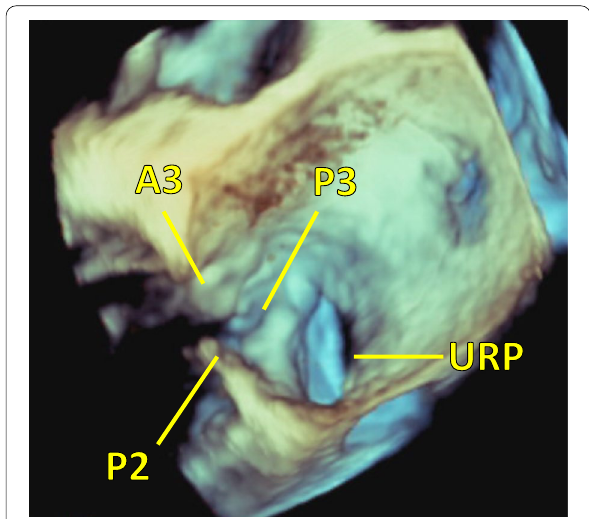
Fig. 2 Preoperative three-dimensional transesophageal echocardiography. Preoperative three-dimensional transesophageal echocardiography showed there was an unroofed portion (20 10 mm) at the atrial side between segments P2 and P3 of the × posterior mitral leaflet. P2 P2 segment of posterior mitral leaflet, P3 P3 segment of posterior mitral leaflet, A3 A3 segment of anterior mitral leaflet, URP unroofed